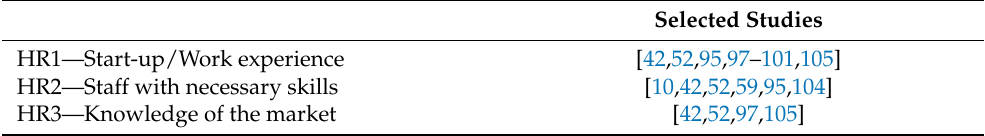
Table 4. Construction of the human resources factor from the literature.